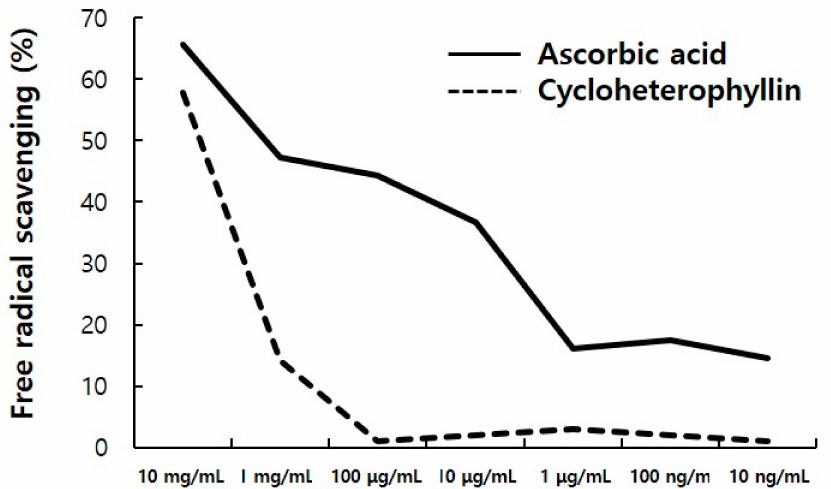
Figure 5. Free radical scavenging of cycloheterophyllin by the DPPH assay. The cyclohetero- phyllin has an antioxidant ability similar to ascorbic acid, positive control in high concentration of